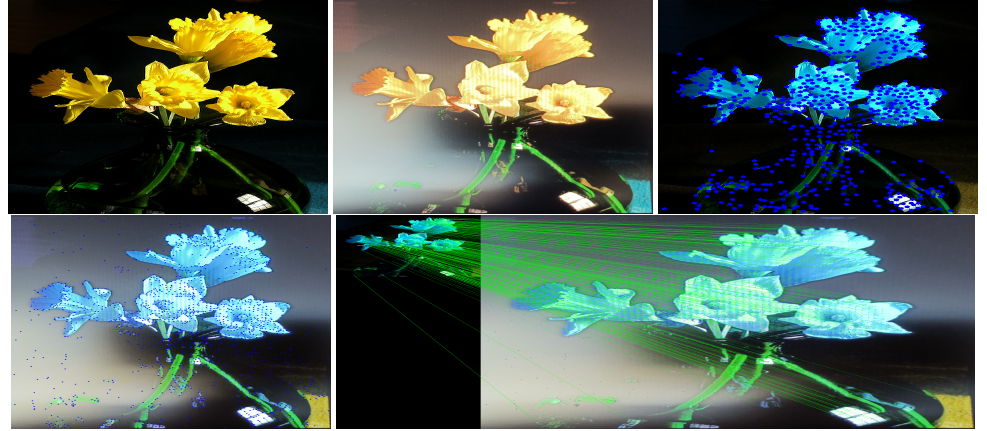
Figure 14. ( Illumination ) Row 1: Left (original image), Middle (attacked images.), Right (result- ing point of original image by SuperPoint’s detector). Row 2: Left (resulting point of attacked image by SuperPoint’s detector), Right (the green lines show the correct correspondences after blurring attacks).